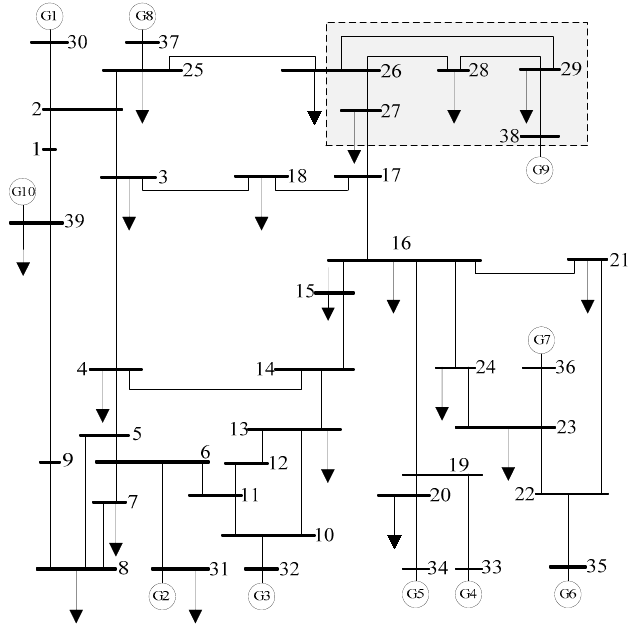
Figure 2. Original IEEE 39-bus system.